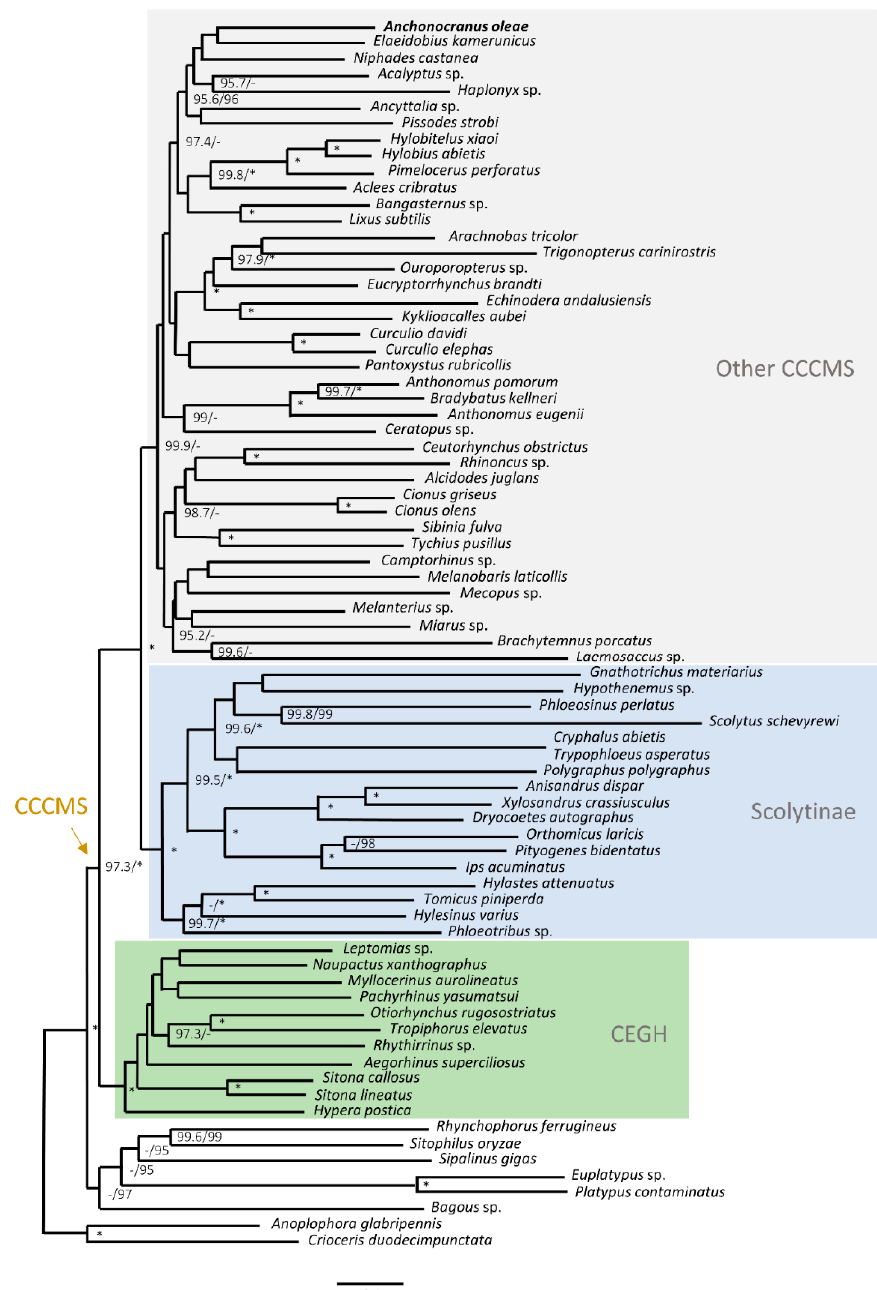
Figure 5. Phylogenetic position of Anchonocranus oleae among 73 other species of Curculionidae, with Anoplophora glabripennis (Cerambycidae) and Crioceris duodecimpunctata (Chrysomelidae) as outgroups. The tree was constructed using maximum likelihood based on a nucleotide alignment of 12 mitochondrial protein-coding genes. Node support values: SH-aLRT (%)/ultrafast bootstrap (%); values < 95% are not shown or represented by a hyphen (-); values of 100% are represented by an asterisk (*).